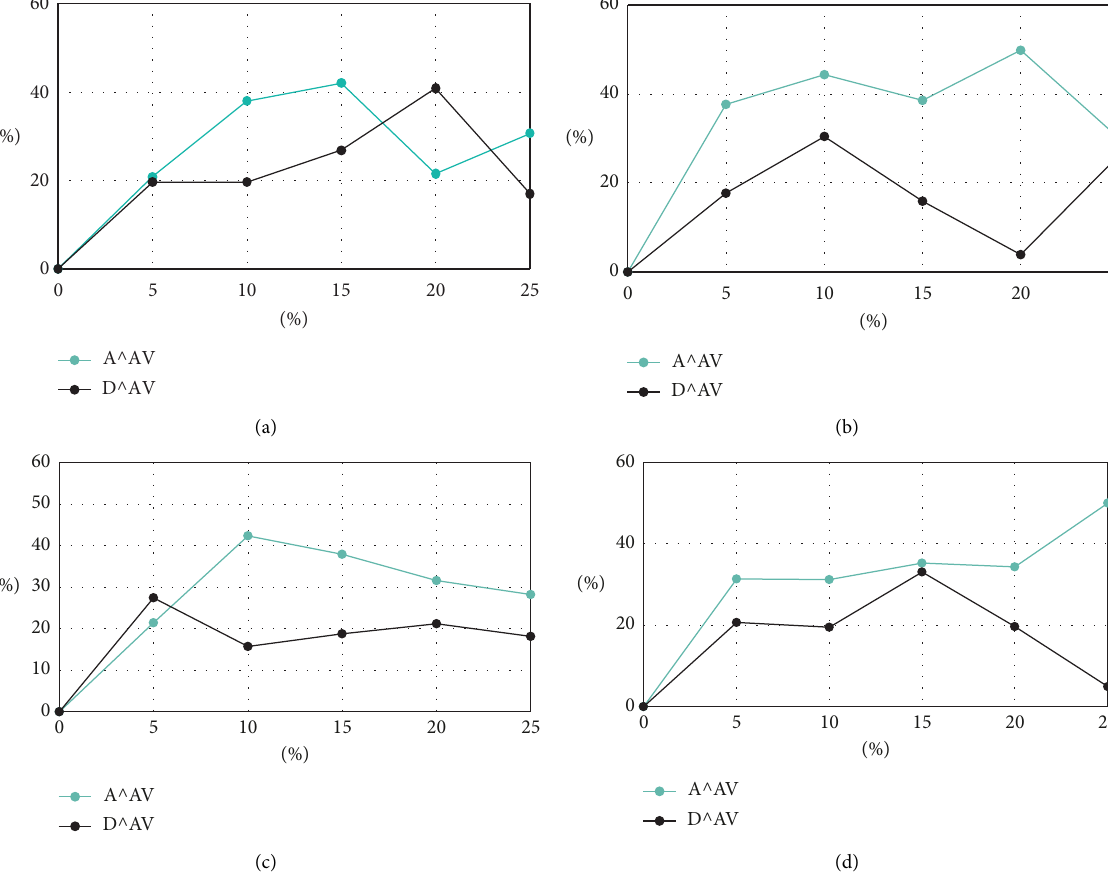
Figure 13: A AV and D AV evolution, from 0% to 25% of tolerance factor e . (a) Case study 1. (b) Case study 2. (c) Case study 3. (d) Case study